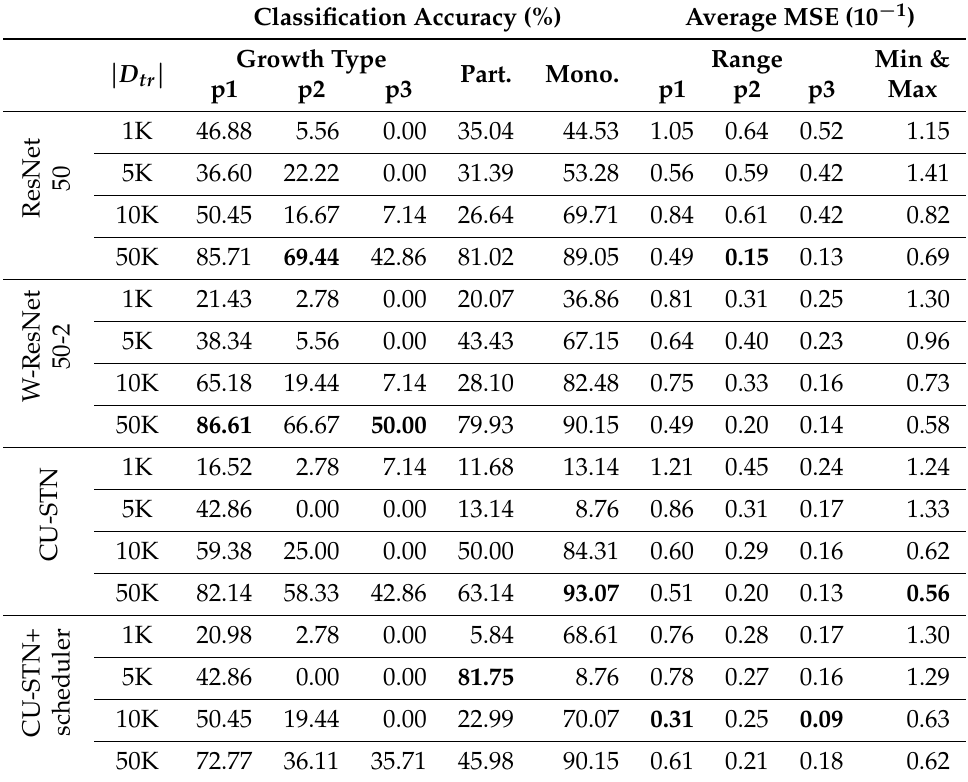
Figure 6. Comparison of F1 score and accuracy of the ( a ) superiority and ( b ) monotonicity subtasks for synthetic data. Table 6. Performance for all subtasks in human-labeled real test data (500 samples; part., the number of partitions; mono.,